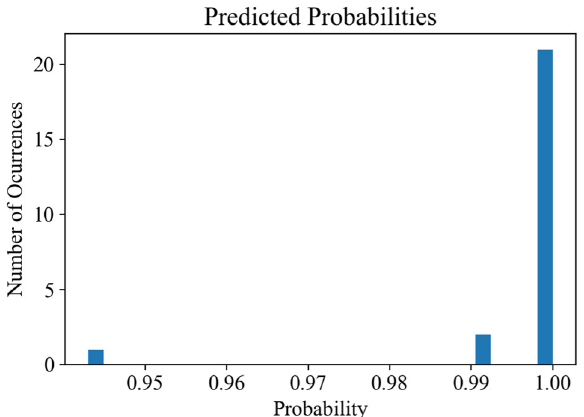
Fig. 14 Fitted GPR representing the failure probability for shear stress levels at 2.0% nominal strain.